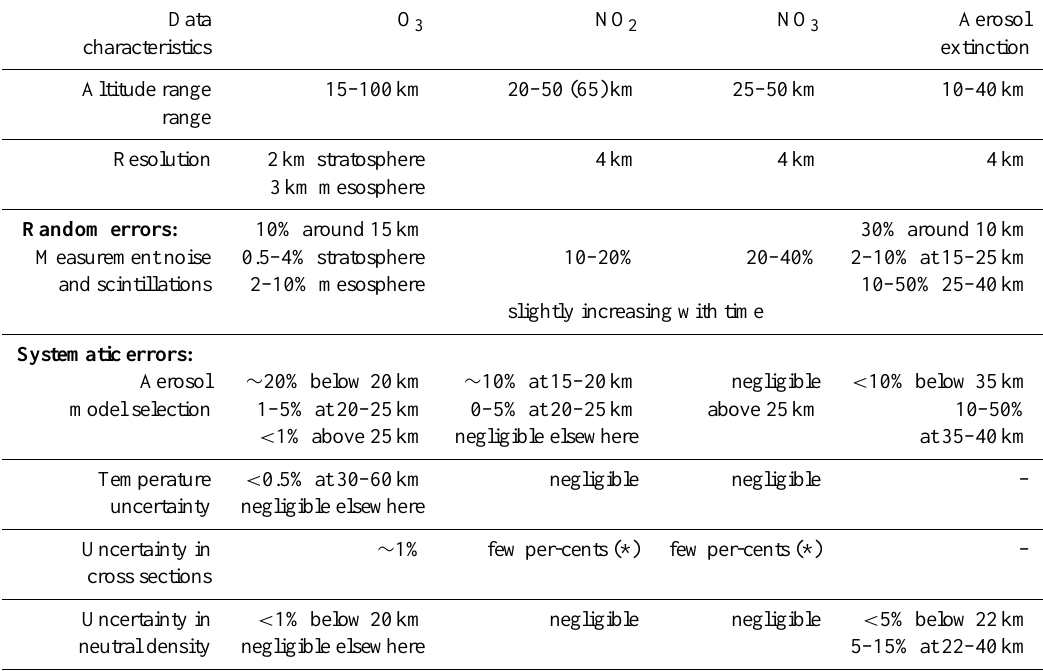
Table 3. GOMOS data characteristics and error contributions due to systematic and random errors. The values correspond to the night-time measurements. For NO 2 the higher altitude limit corresponds to case with high NO 2 concentration. (*) The impact of the systematic errors due to the uncertainty in cross sections for NO 2 and NO 3 is only rough